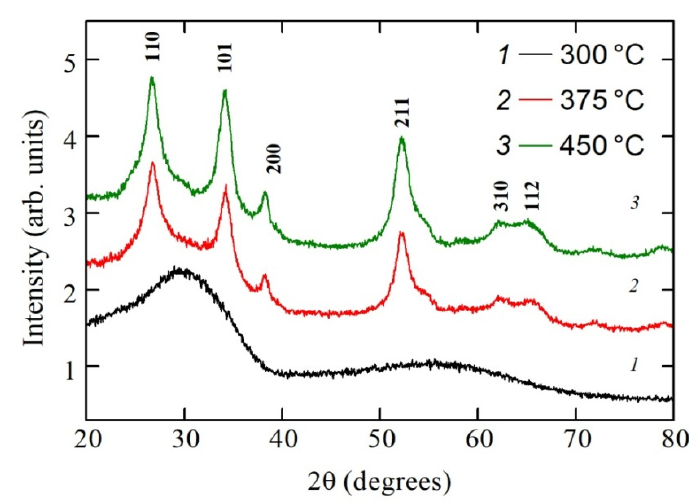
Figure 2. XRD patterns of the SnO 2 − δ films deposited on glass substrates by reactive magnetron sputtering of tin in the argon–oxygen atmosphere (with oxygen content of about 1 vol %) with the following annealing in air.